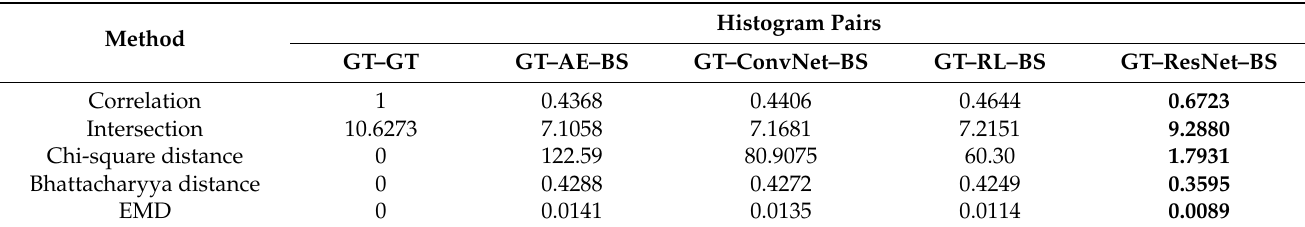
Table 3. Histogram similarity assessment. The similarity of the histograms of the predicted images using the bone suppres- sion models and their corresponding ground truths are measured. Bold numerical values denote superior performance in respective rows.